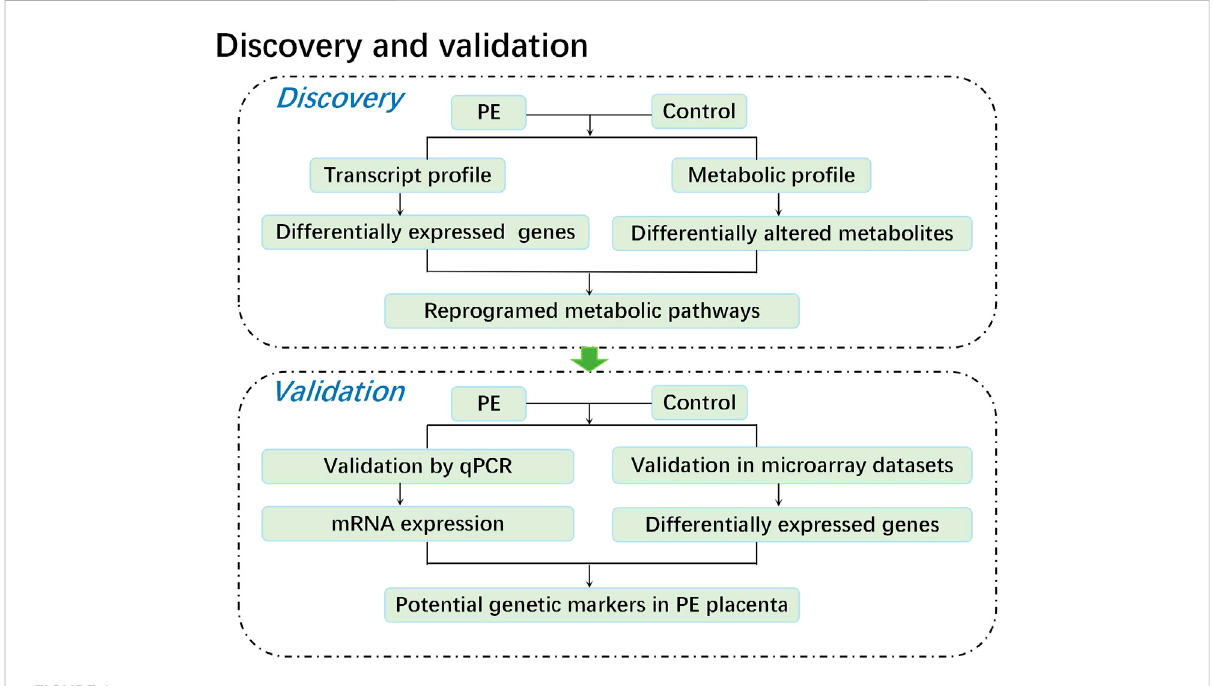
FIGURE 1 Experimental fl ow